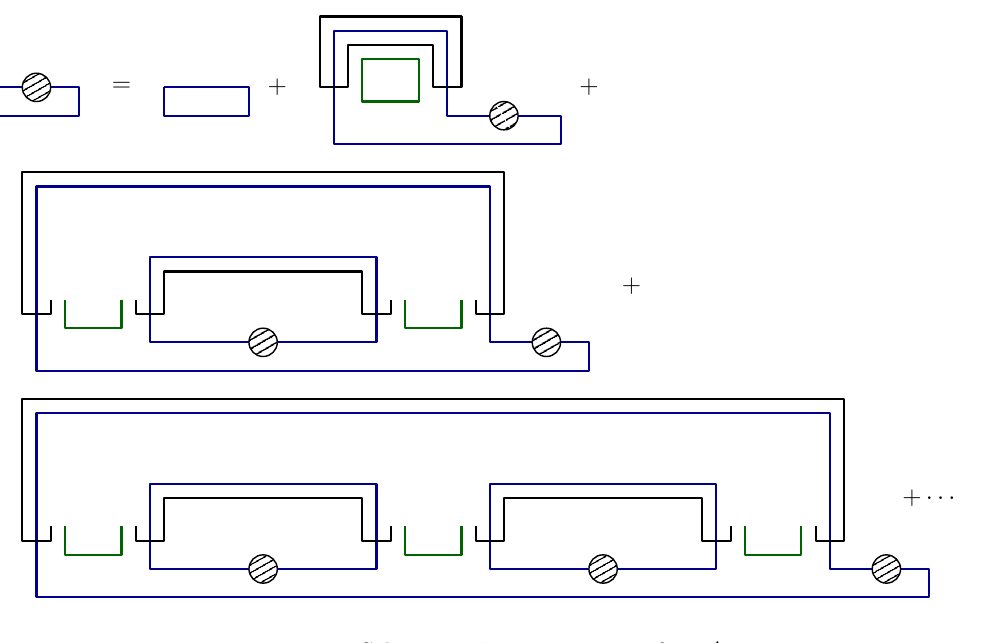
Figure 13 . Schwinger-Dyson equation for R 0